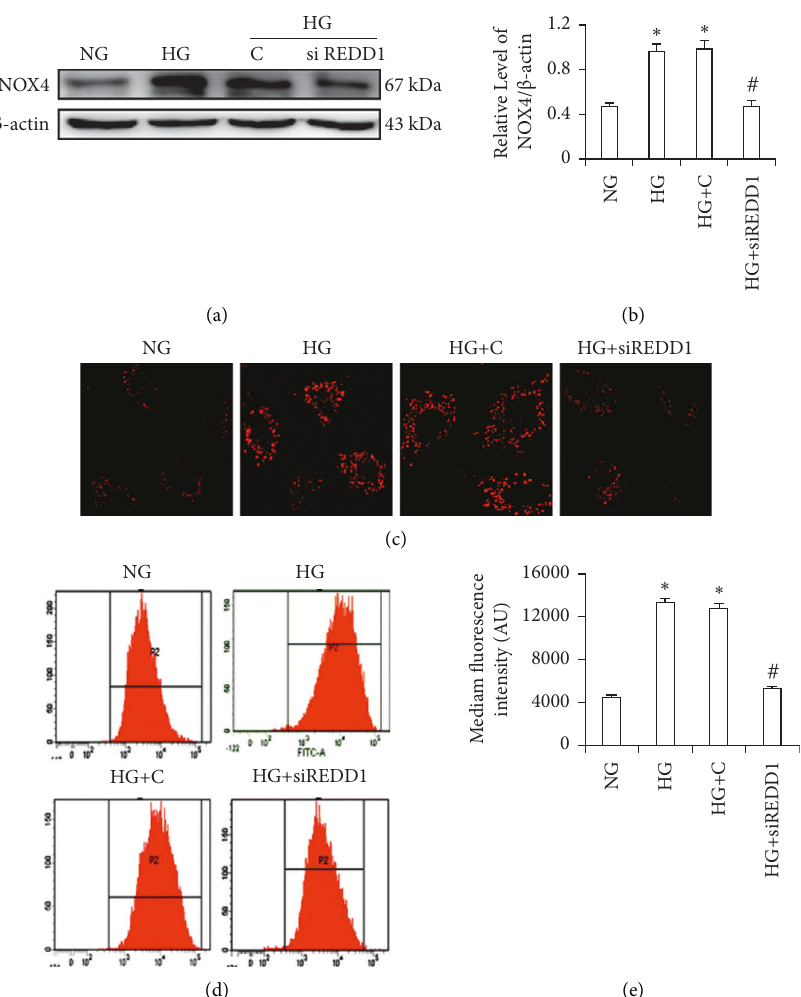
Figure 7: Knockdown of REDD1 inhibits HG-induced ROS production in HK-2 cells. (a, b) Western blot detected NOX4. (c) Mito- chondrial ROS was detected by the confocal microscope. (d, e) Intracellular ROS was detected by flow cytometry. Values are expressed as means SD ( n 6 per group). NG: 5.6 mM D-glucose; HG: 30mM D-glucose; HG+(C) 30mM D-glucose plus scramble. HG+siREDD1: (cid:31) 30mM D-glucose plus REDD1 ±